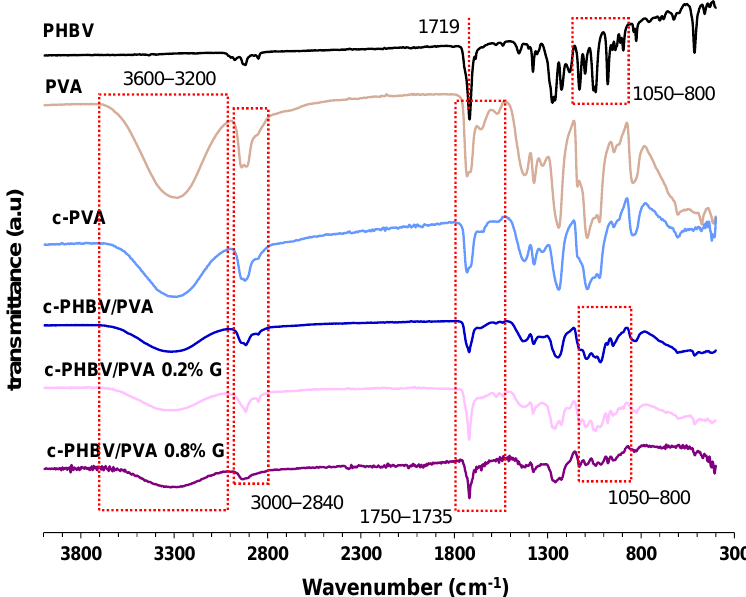
Figure 4. Fourier transform infrared spectroscopy (FTIR) spectra in the region 4000–300 cm −1 of the semi-IPN with and without G nanoparticles. Neat PVA, crosslinked PVA (c-PVA), and neat PHBV are also included as reference samples.